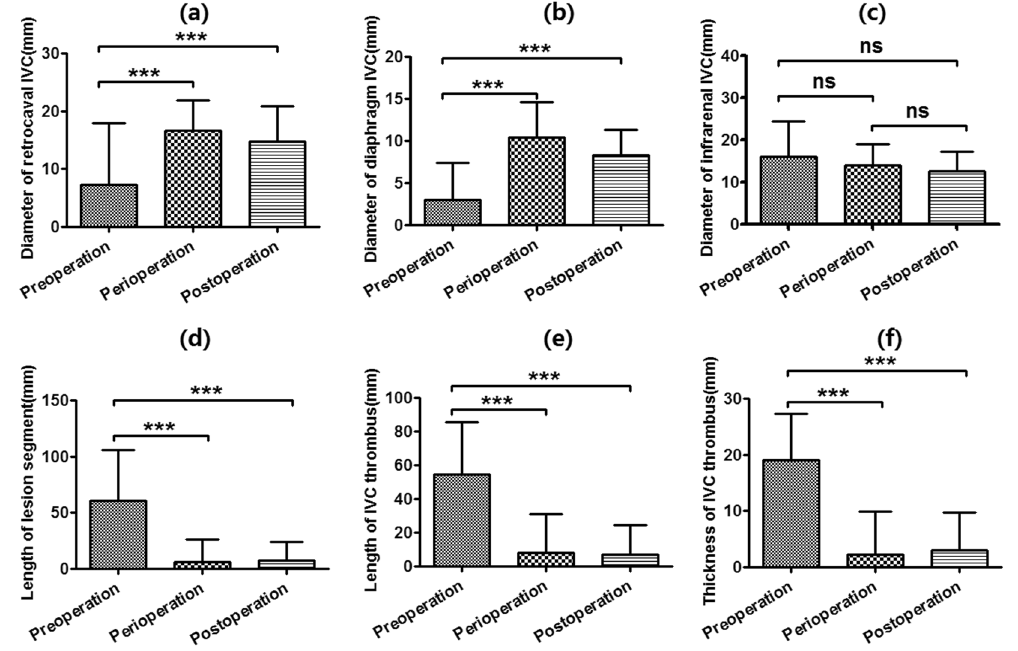
Figure 5. Results of color Doppler ultrasound test. The diameter of retrocaval IVC ( a ) and diaphragm IVC increased ( b ) compared to the diameter prior to intervention. The diameter of infrarenal IVC ( c ) did not changed significantly. The length of lesion segment ( d ), length ( e ) and thickness of IVC thrombus ( f ) decreased significantly. *** p < 0.0001, ns = not